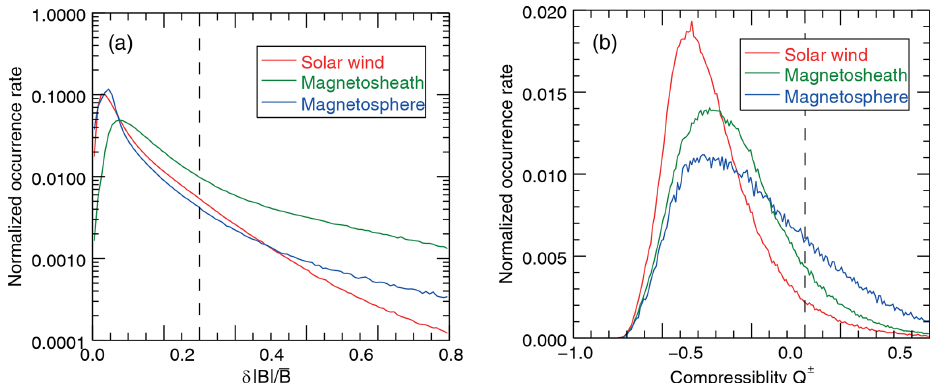
Figure 2. (a) Normalized occurrence rate of the total magnetic field fluctuations δ | B | /B in the solar wind (blue), magnetosheath (green), and magnetosphere (red) during 4 years of MESSENGER observations. (b) Normalized occurrence rate of the compressibility index Q ± for magnetic fluctuations with δ | B | /B > 0 . 3. Positive or negative Q ± values indicate whether the compressional or the transverse part of the magnetic fluctuations is dominant, and Q ± > 0 . 3 values are considered as strong compressional fluctuations.